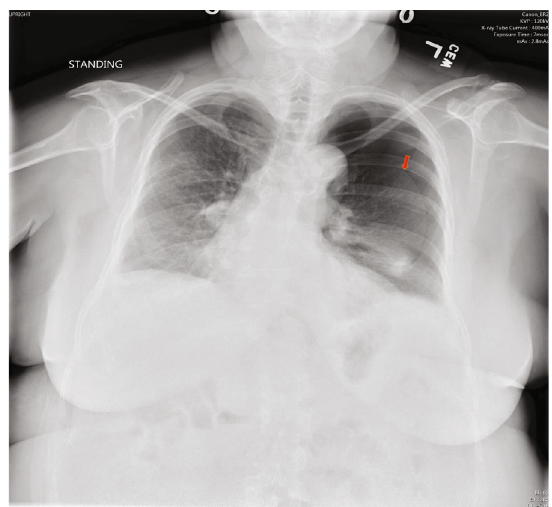
Figure 2: Chest X-ray showing moderate right-sided apicolateral pneumothorax (depicted by red arrow).